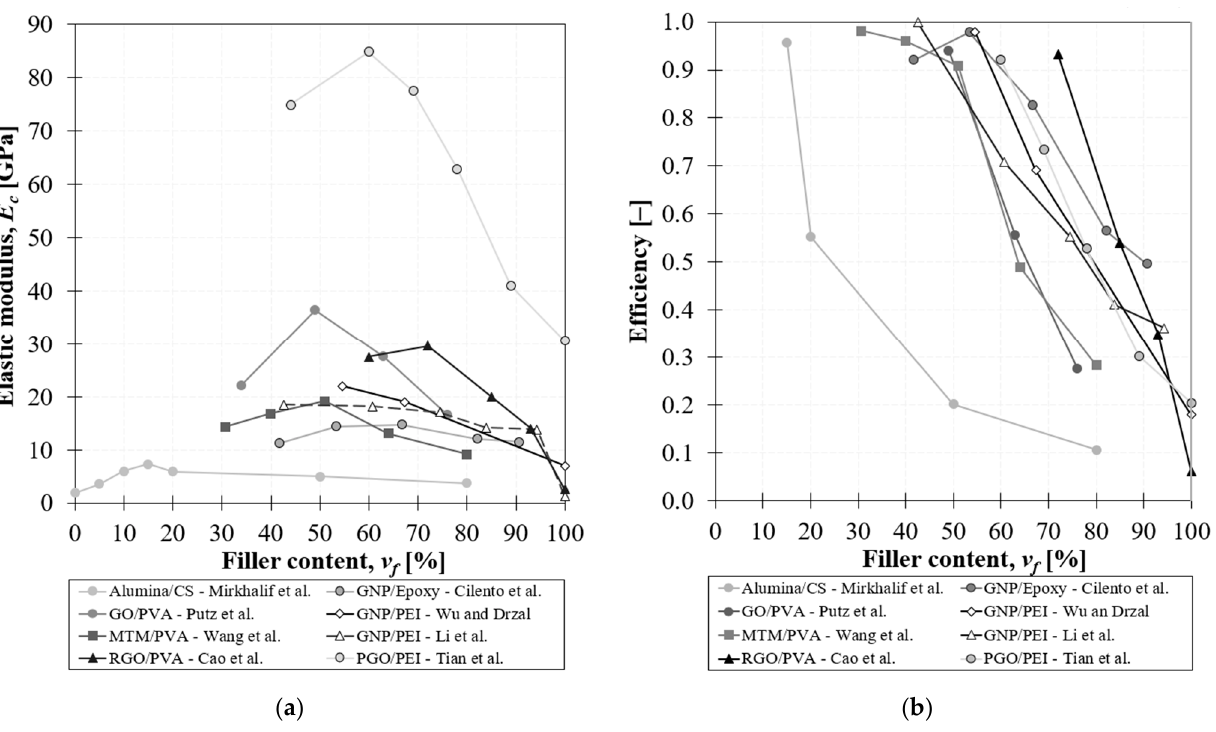
Figure 4. Drop of elastic modulus ( a ) and efficiency ( b ) at high filler content according to the state of art [16,36,42,45,46,54,62,65–67].